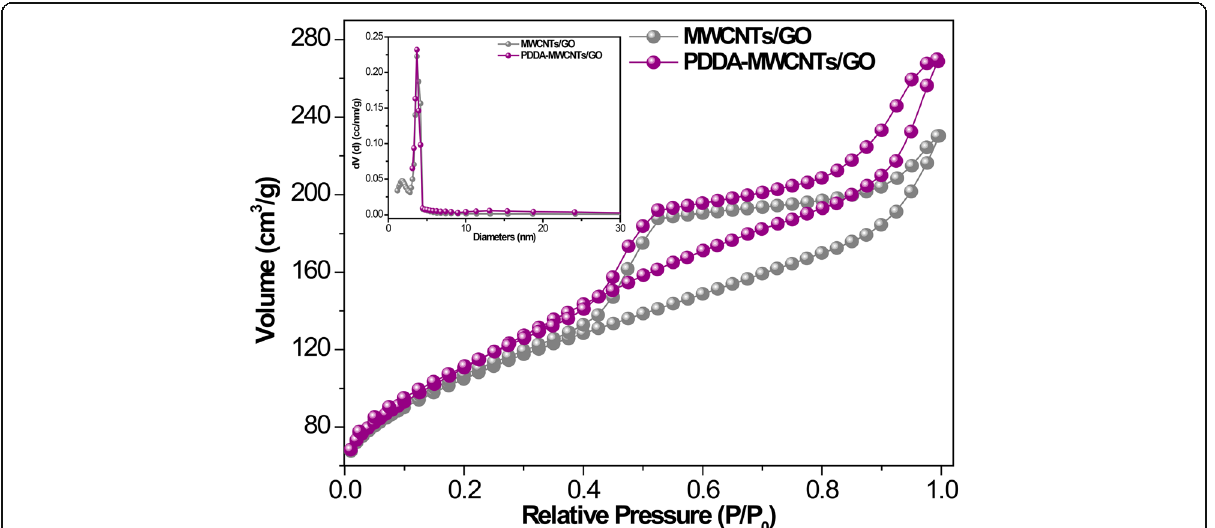
Fig. 4 N 2 adsorption – desorption isotherms of MWCNTs/GO and PDDA-MWCNTs/GO membranes. The inset shows the pore size distribution of the MWCNTs/GO and PDDA-MWCNTs/GO membranes